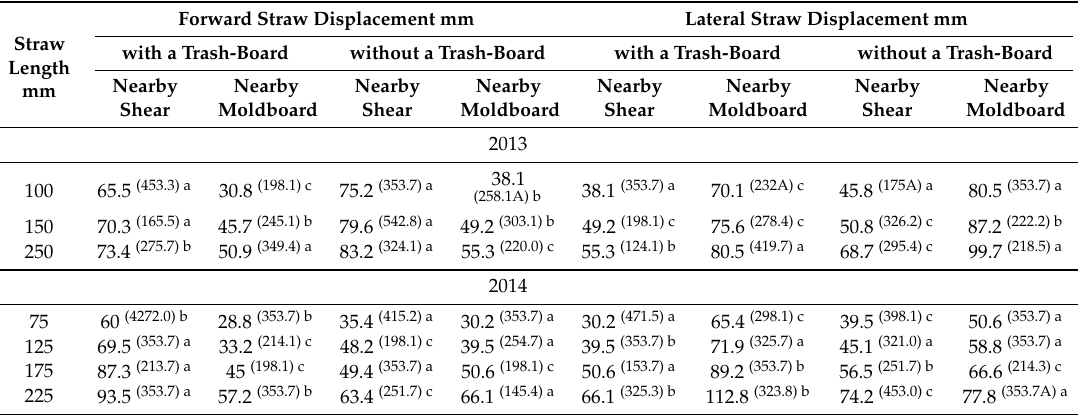
Table 3. Average straw displacement at tow water content by three parallel passes with and without a trash-board in the field.